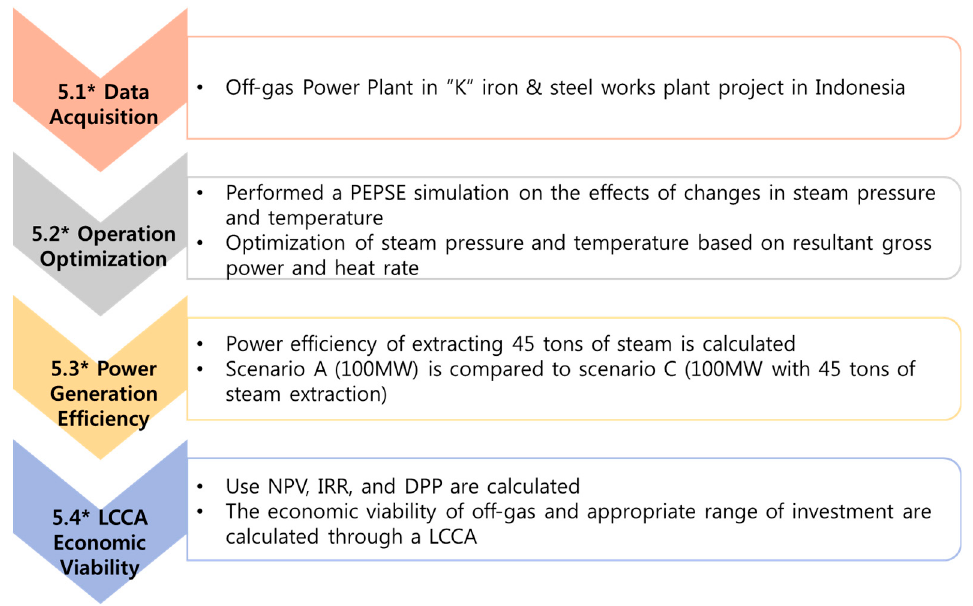
Figure 3. Research Framework and Process. (* number indicates the section number in the paper).